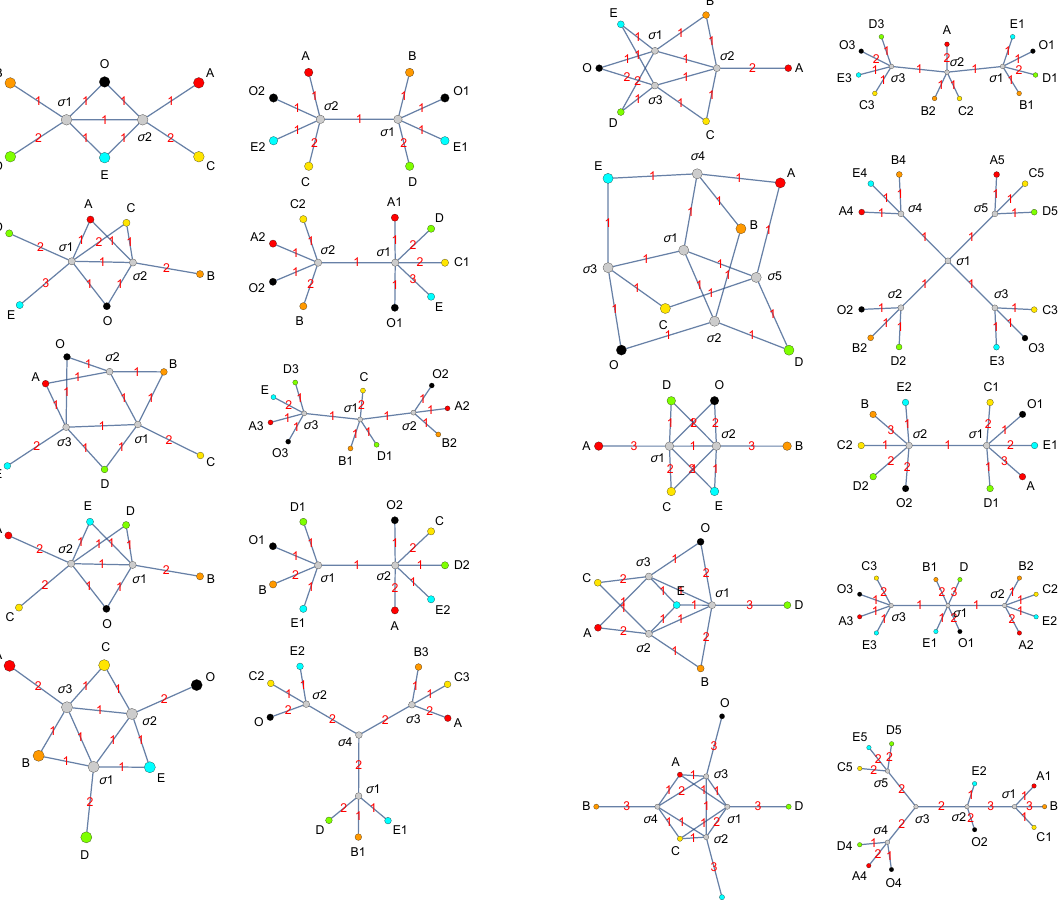
Figure 12. The first and third columns show graph realizations of the extreme rays of the HEC 5 which cannot be realized by simple trees. Rather than their original form from [28], here we show the graphs of minimal number of vertices obtained by [32]. To the right of each graph, we provide a non-simple tree realization of the same extreme ray, obtained through repeated application of the graph operations described in appendix